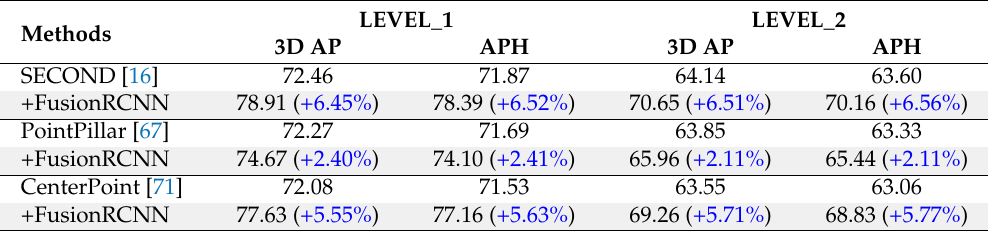
Table 7. Ablations on different one-stage detectors on Waymo validation set. +FusionRCNN donates plugging FusionRCNN into different popular single-stage detectors. The performance improvements are painted in blue.